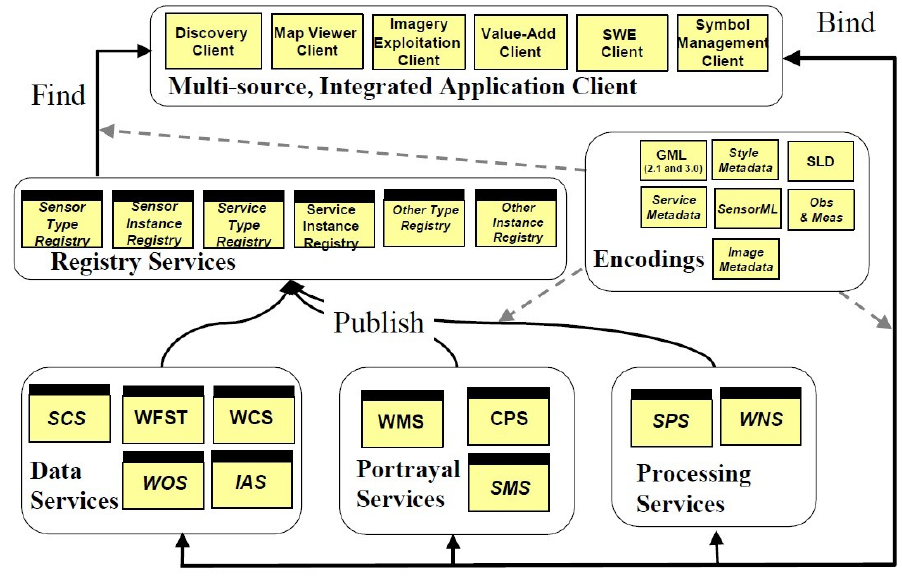
Figure 2. OWS framework